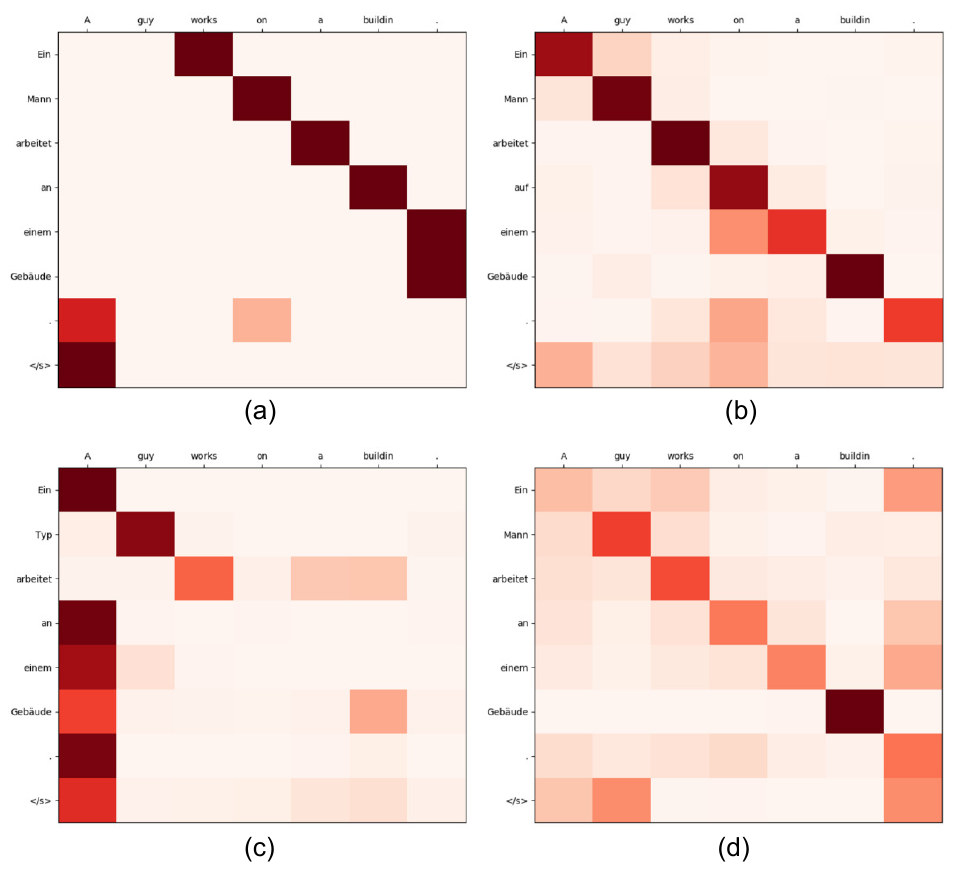
Figure 4. Attention matrices produced by the attention mechanism in the problem of bilingual translation, for the translation of the sentence (horizontal axis) “A guy works on a building”. ( a ) Attention matrix for manual CFE, the output (vertical axis) is “Ein Mann arbeitet an einem Gebäude”. ( b ) Attention matrix for random CFE, the output is “Ein Mann arbeitet auf einem Gebäude”. ( c ) Attention matrix for Transformer model, the output is “Ein Typ arbeitet an einem Gebäude”. ( d ) Attention matrix for LSTM, the output is “Ein Mann arbeitet an einem